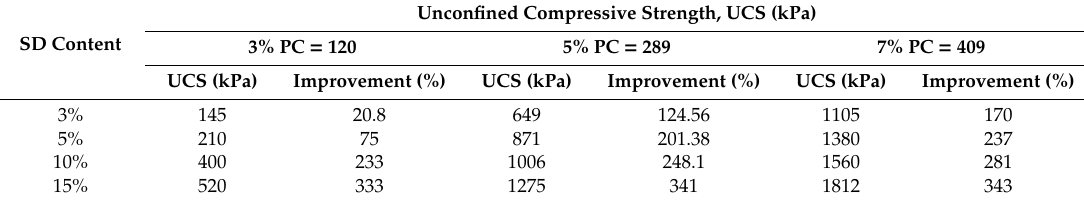
Table 9. UCS results after sulphate exposure in presence of SD (28 days